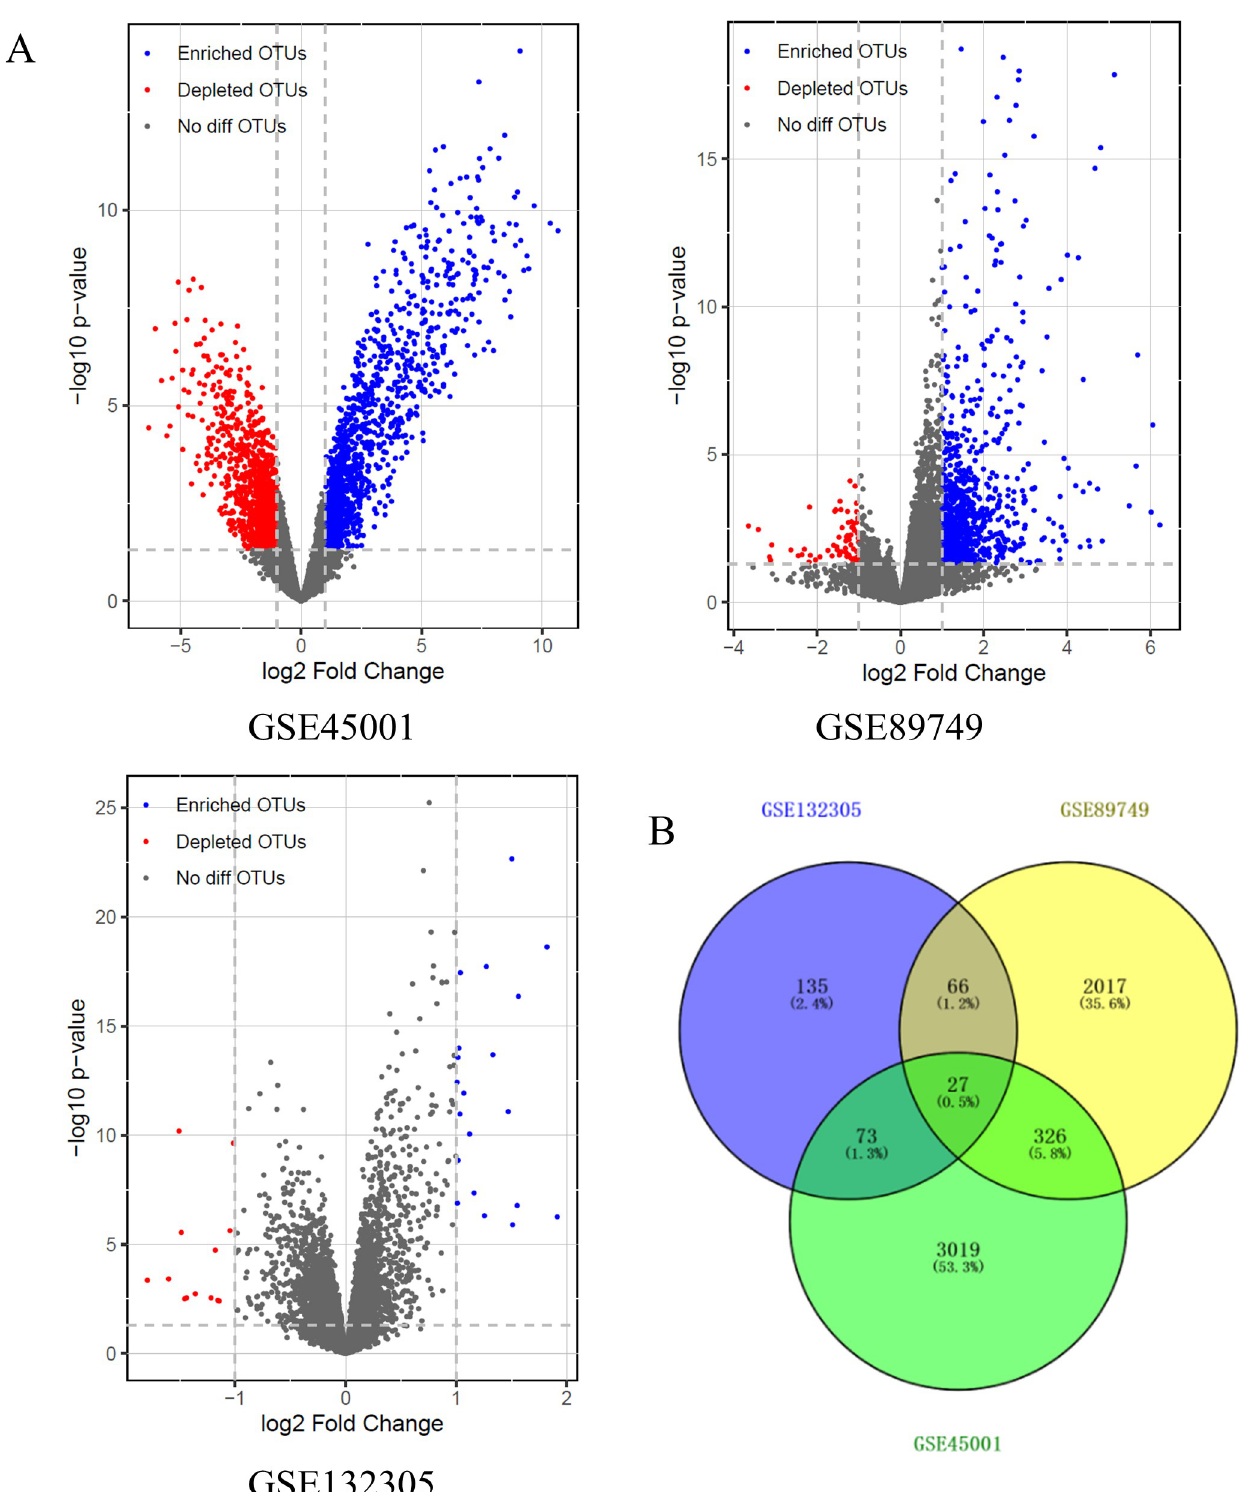
Fig 1. Identification of DEGs (A) volcanic plot of the three datasets (B) Venn plot of DEGs among the three datasets.